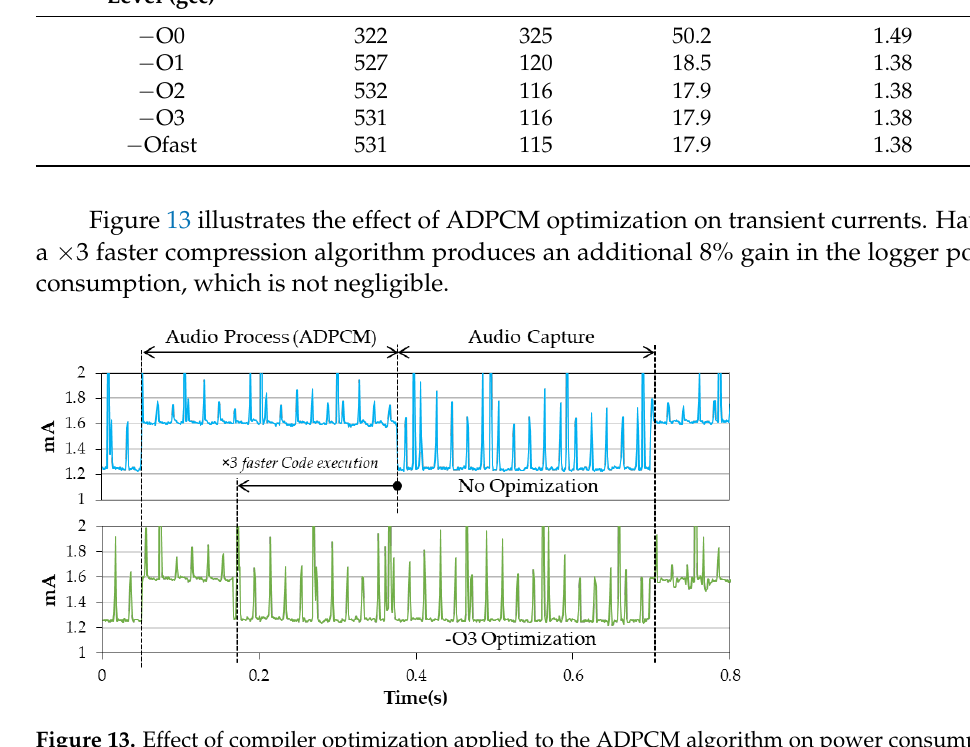
Table 5. Average supply current (mA) measured during Capture and Process states for various tick rates and low-power idle strategies. Optimization Level